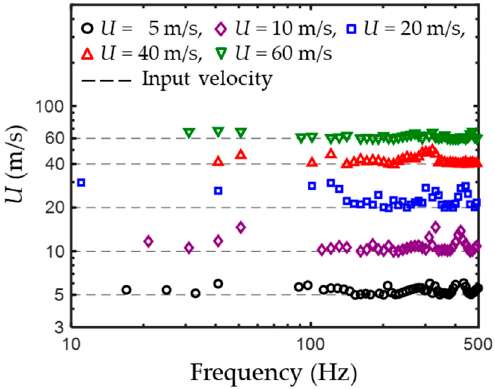
Figure 9. Predicted flow velocities in the fluid pipes.